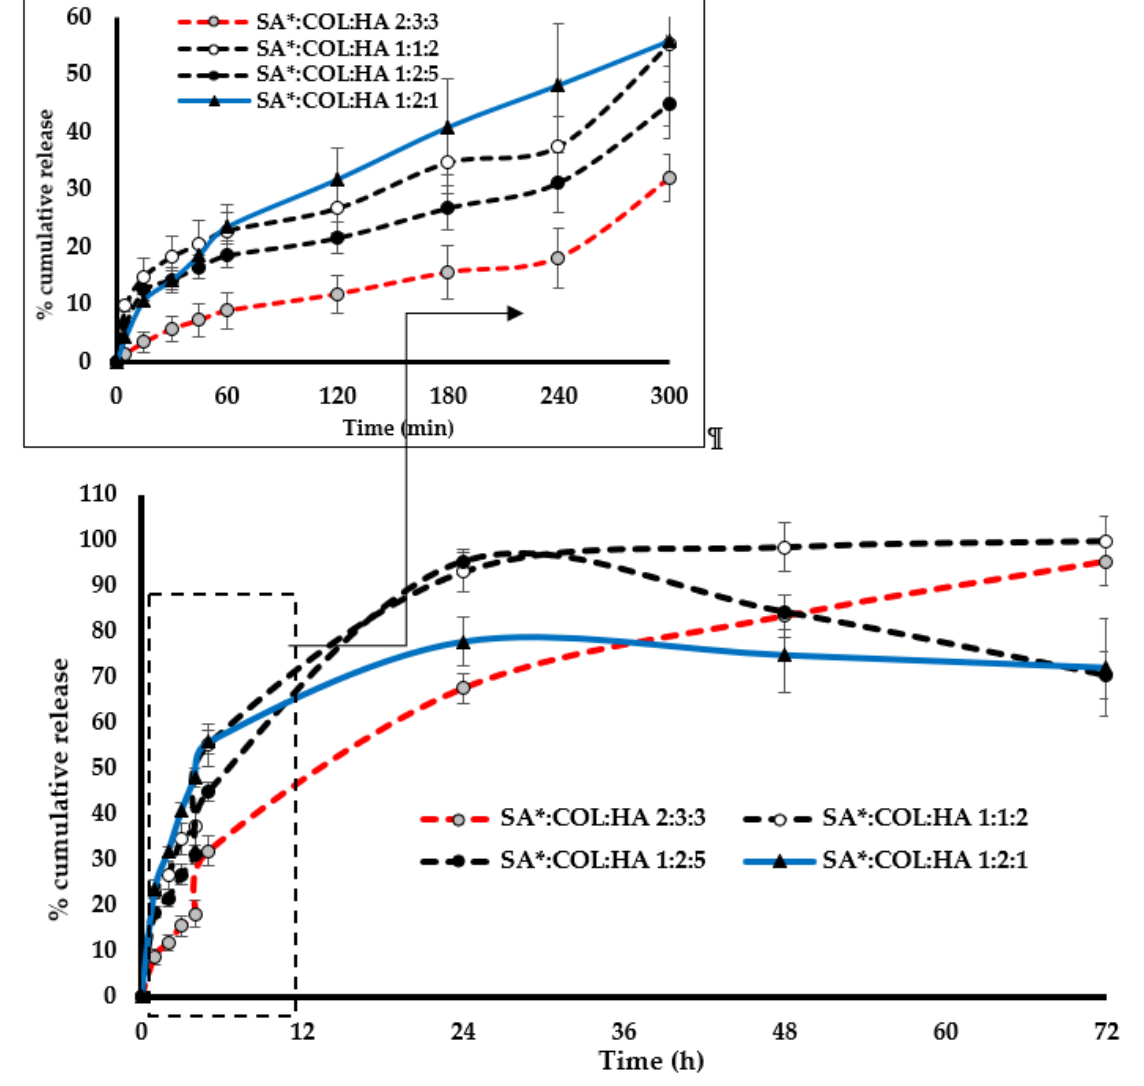
Figure 9. Percentage cumulative protein release profiles of 75 µg/g BSA loaded SA*:FCOL:HA scaffolds ( n = 3 ± SD). Table 3. BSA release data fitted to various kinetic